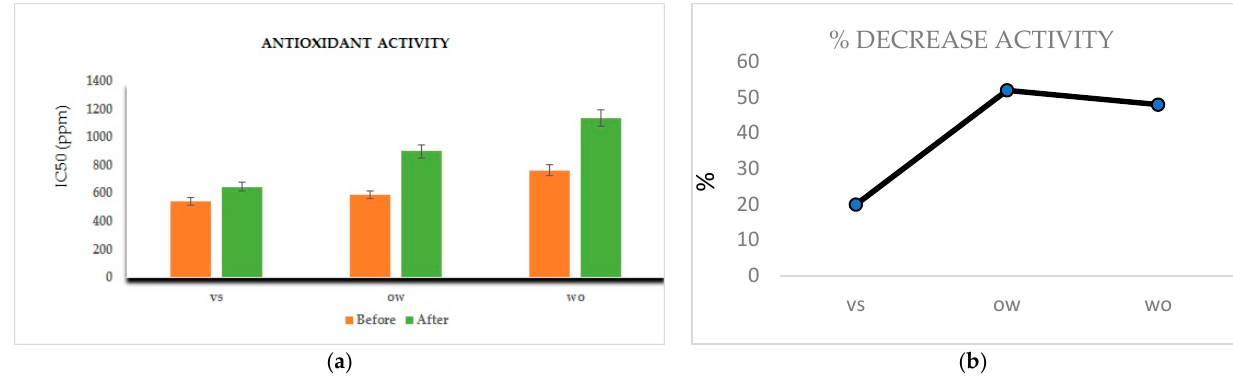
Figure 3. Evaluation of cream stability ( a ) pH; ( b ) spreadability; ( c ) viscosity; ( d ) stickiness.